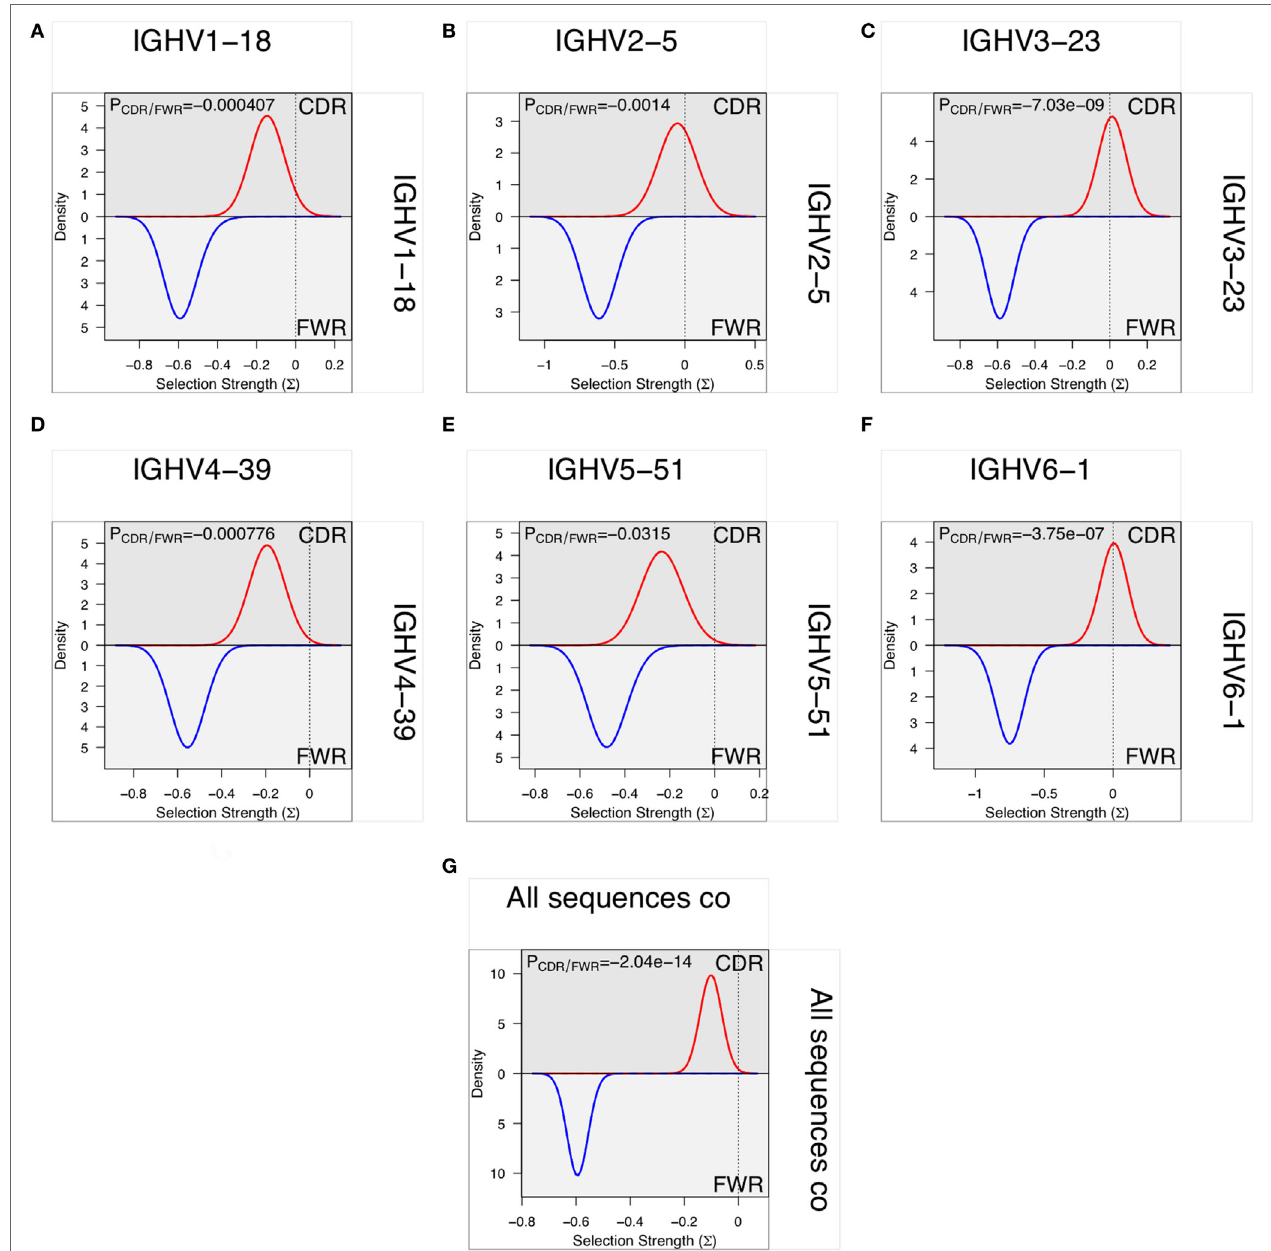
FigUre 13 | Analysis, using BASELINe (33, 34), of selection pressure on the diversification of residues of the framework region (FR) and complementarity determining region (CDR) with an origin in six germline genes [IGHV1-18 (a) , IGHV2-5 (b) , IGHV3-23 (c) , IGHV4-39 (D) , IGHV5-51 (e) , and IGHV6-1 (F) ]. There is a profoundly more negative selection of diversification of residues of FR2 and FR3 than of CDR1 and CDR2 but there is no evidence for positive selection in the substitution pattern of CDR of sequences derived from any of the individual germline genes. Indeed, overall there is evidence for negative selection for substitution also in the CDR (g)